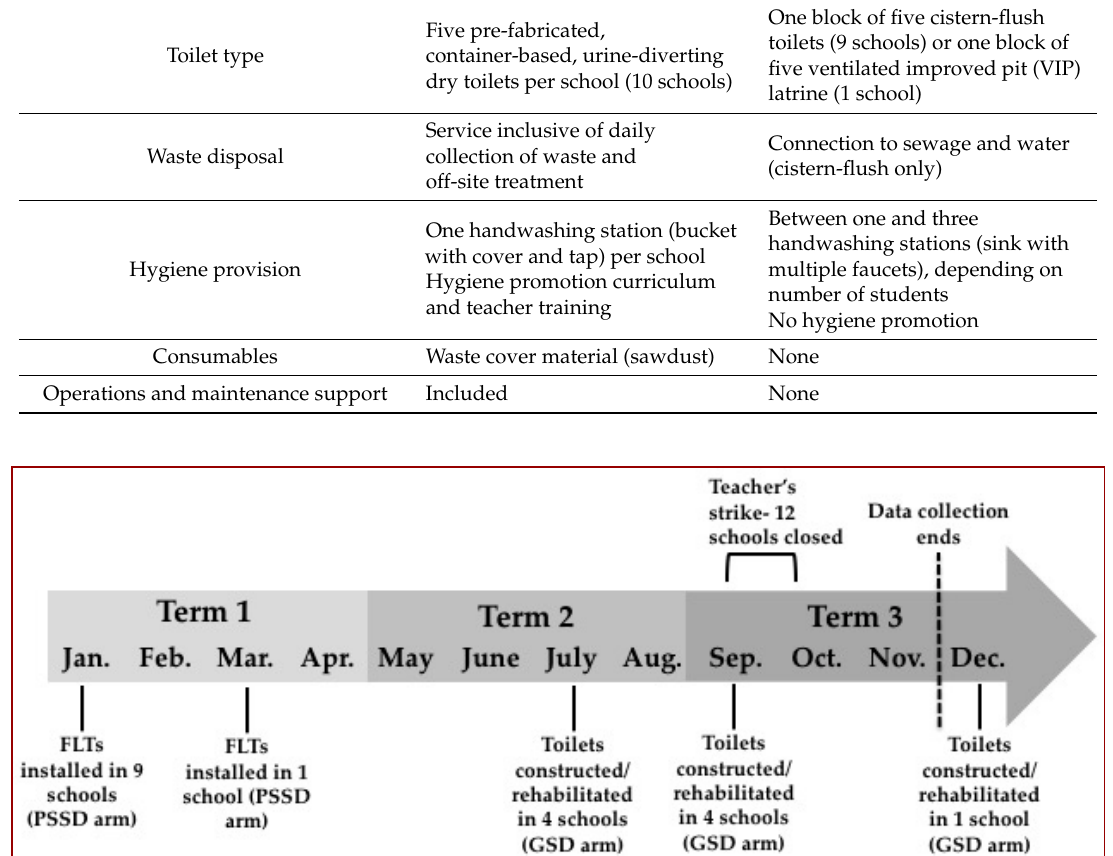
Figure 1. Timeline of study components .